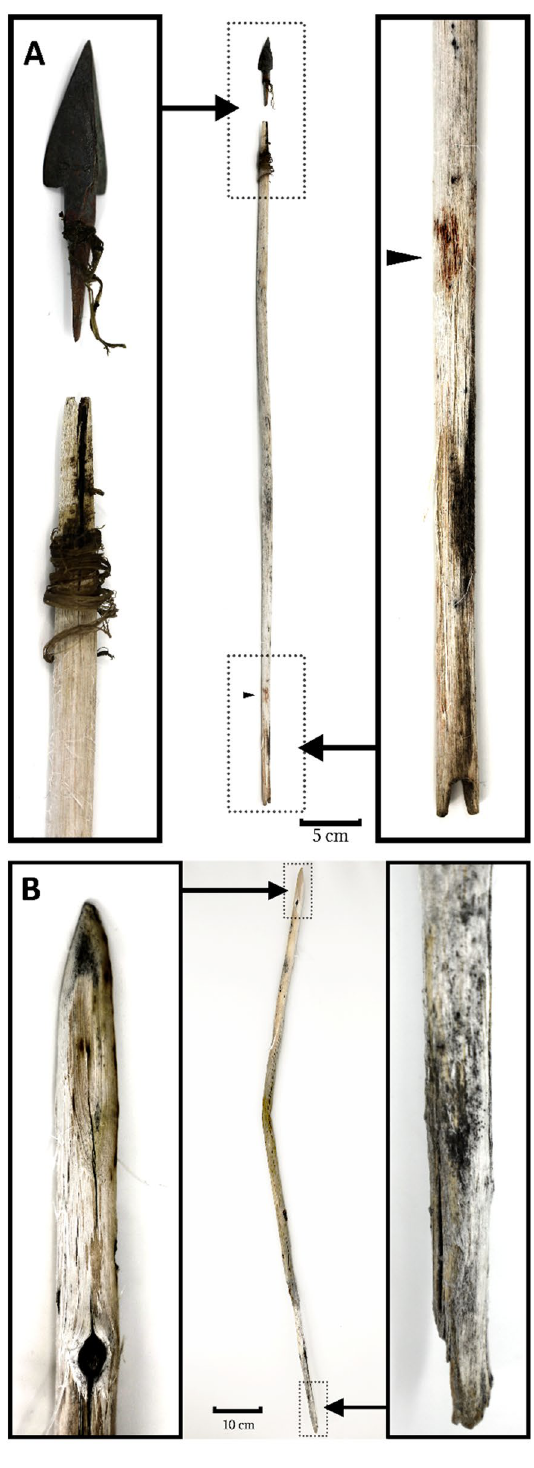
Figure 4. ( A , top): intact, bronze-tipped and sinew-hafted arrow recovered from Tsengel Khairkhan (Artifact 35), dating to the late Bronze Age. The nock end has been painted with red pigment. Scale = 20 cm. ( B , bottom): large dart or spear fragment (Artifact 27), narrowed at one end and with scarf joint at the other. Scale = 20 cm. Image: Peter Bittner and Mark